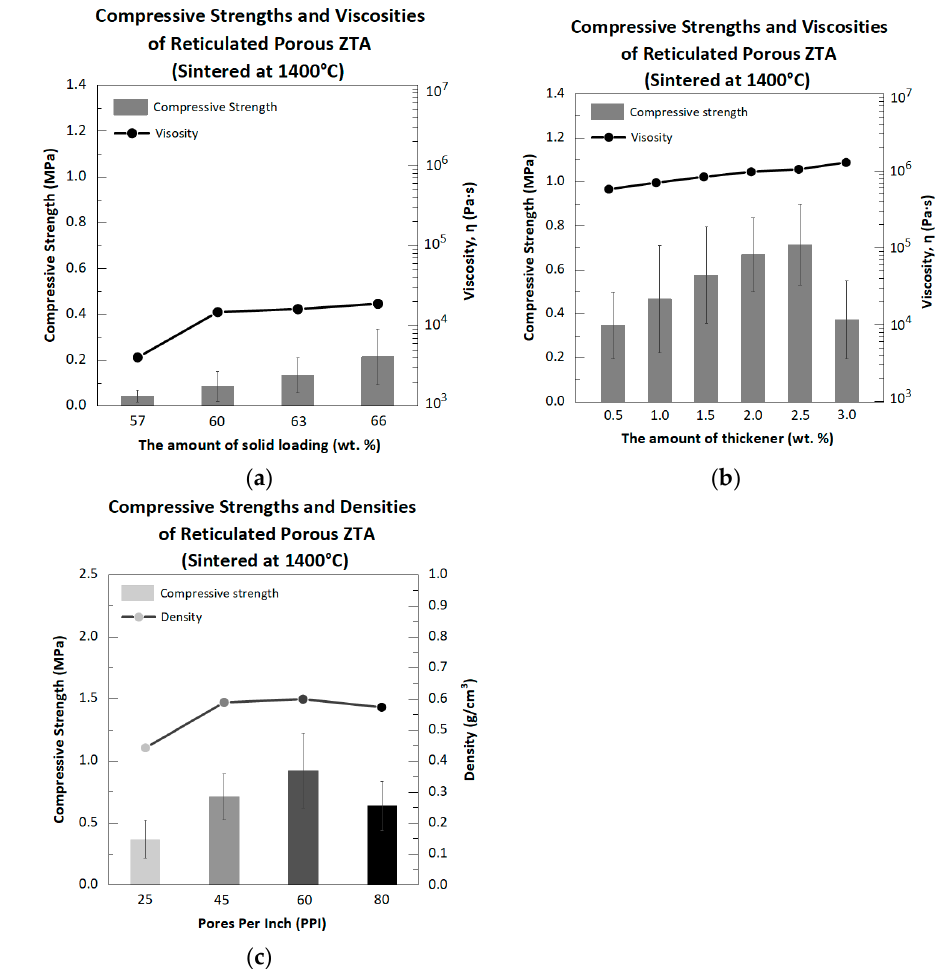
Figure 3. Viscosities at a shear rate of 0.01 s − 1 of the ZTA slurry, and the compressive strengths: ( a ) 57–66 wt.% solid loading, ( b ) 0.5–3.0 wt.% MC, and ( c ) compressive strengths and densities of